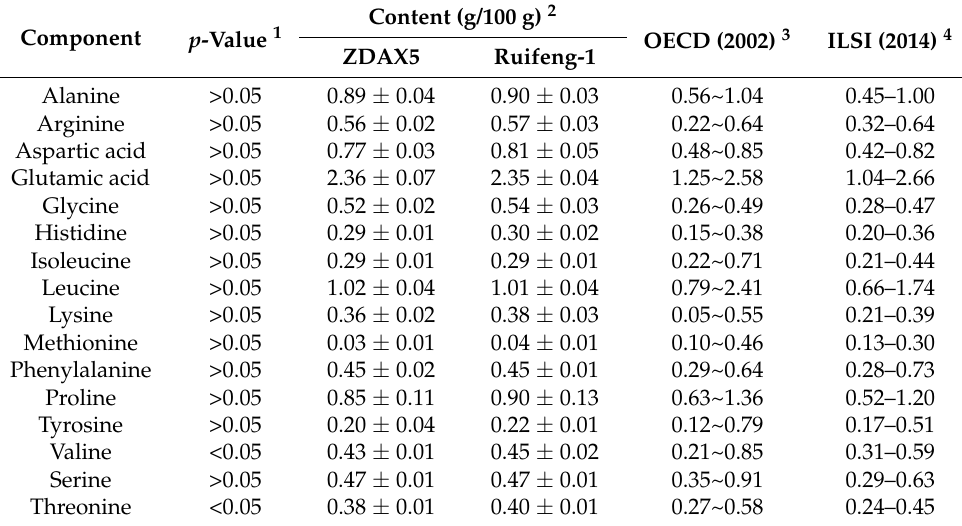
Table 2. Amino acid levels in ZDAX5 maize grain and Ruifeng-1 maize grain.